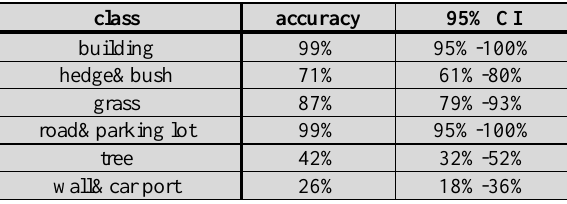
Table 6. User’s accuracy of the individual classes (SVM- classification)